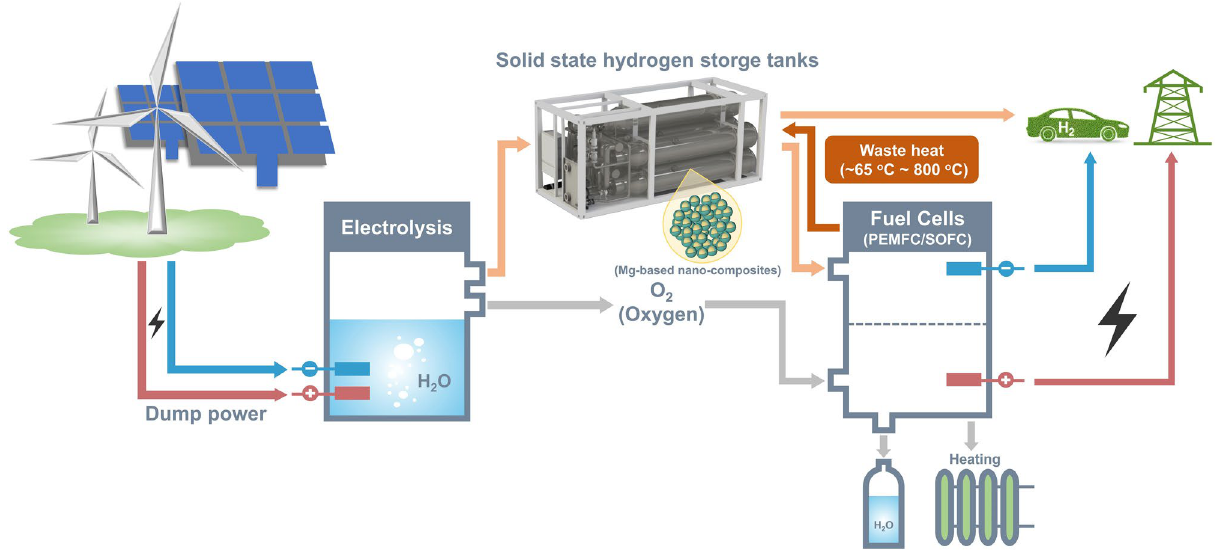
Fig. 11 A vision of the future energy infrastructure (electrolysis system; safety design for the hydrogen storage and transportation device; con- struction of hydrogen system-linked hydrogen vehicles/fuel cell equipment charging